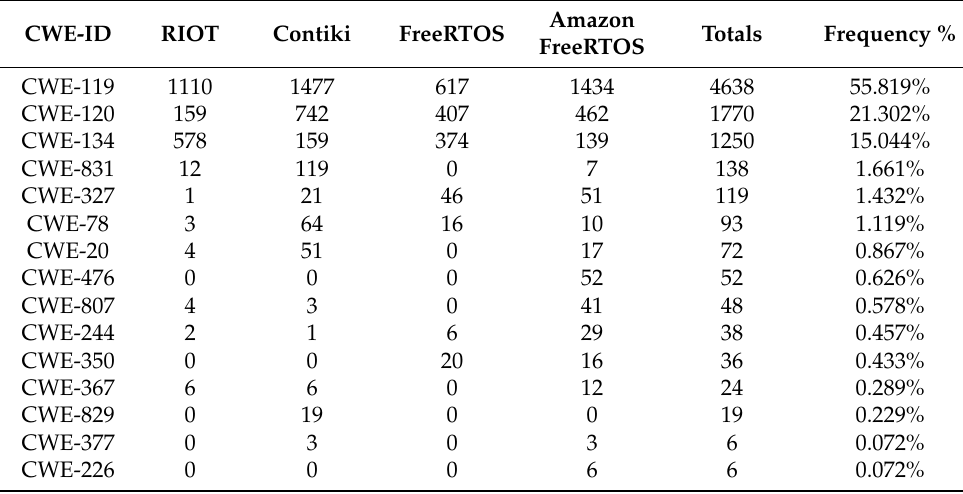
Table 10. Total CWEs of IoT OSs by RATS